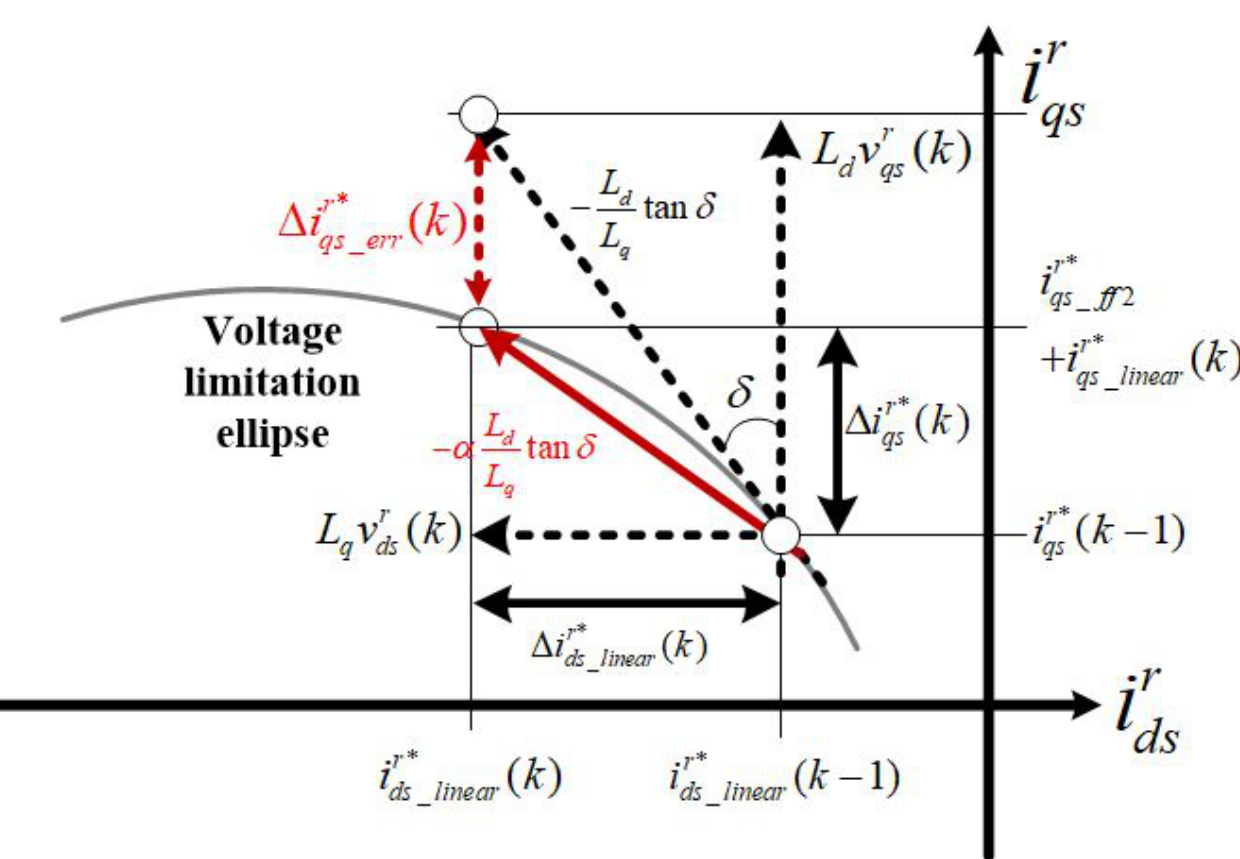
Figure 6. q-axis current reference variation accordance with d-axis current reference